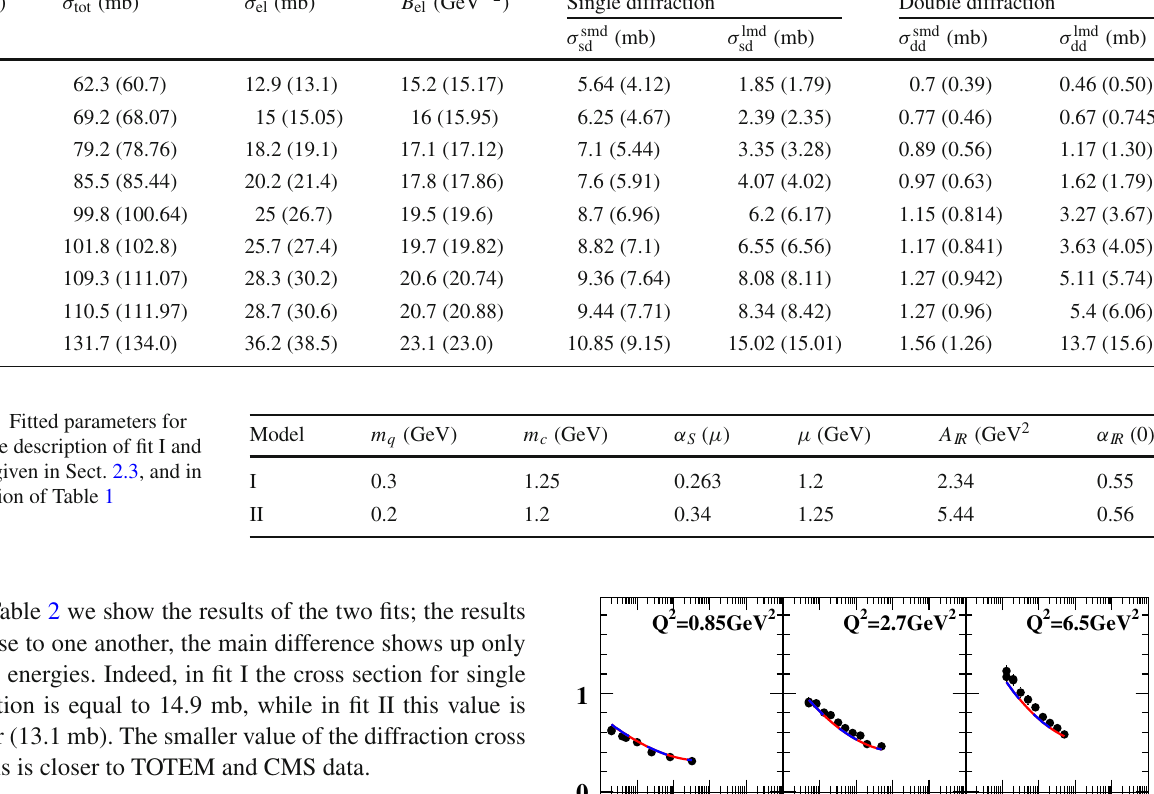
and σ smd sd dd from the dressed Pomeron contributions. The predictions of fit II are shown in brackets